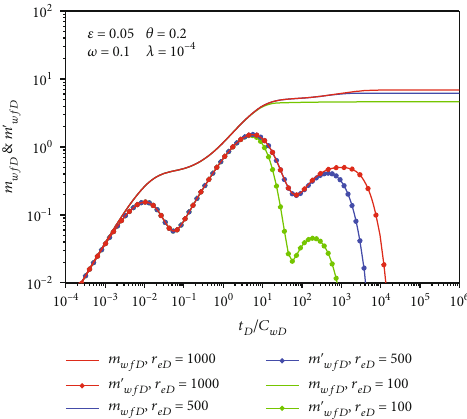
Figure 14: The in fl uence of gas reservoir